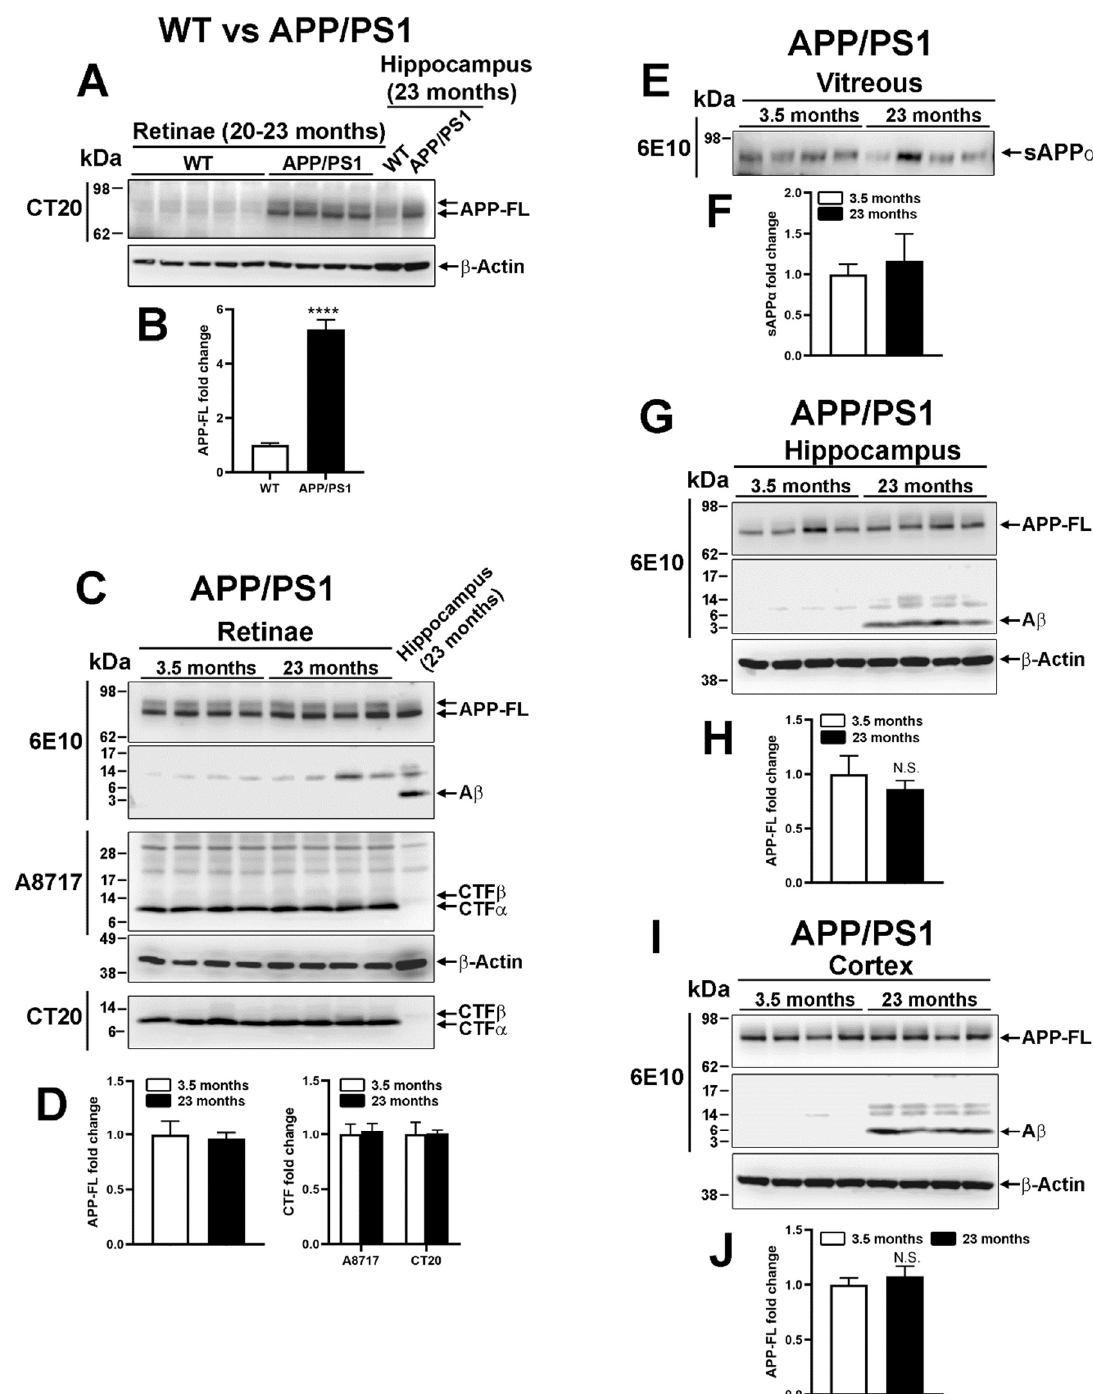
Figure 3. Analysis of amyloidogenic processing in very old APP/PS1 mouse retinae. ( A , B ) Western blotting analysis showed stronger expression of full-length APP (APP-FL) in the retinae of APP/PS1 transgenic mice expressing human APP than in WT samples (unpaired t -test, ****: p < 0.0001). The level of APP-FL was similar to that observed in the hippocampus. ( C , D ) The level of human APP was similar in young and old APP/PS1 retinae. However, A β monomer was only detectable in the hippocampus. CTF α was predominantly expressed in the retina, with no change associated with age, although CT β was observed in hippocampal homogenate, suggesting predominant nonamyloidogenic processing of human APP in the mouse retina. ( E , F ) In very old APP/PS1 mice, the intravitreal level of sAPP α did not differ from that of young animals. ( G – J ) Age-dependent increased synthesis of A β monomer was observed in the hippocampus and cortex of APP/PS1 mice. However, the level of APP-FL did not change in an age-dependent manner.